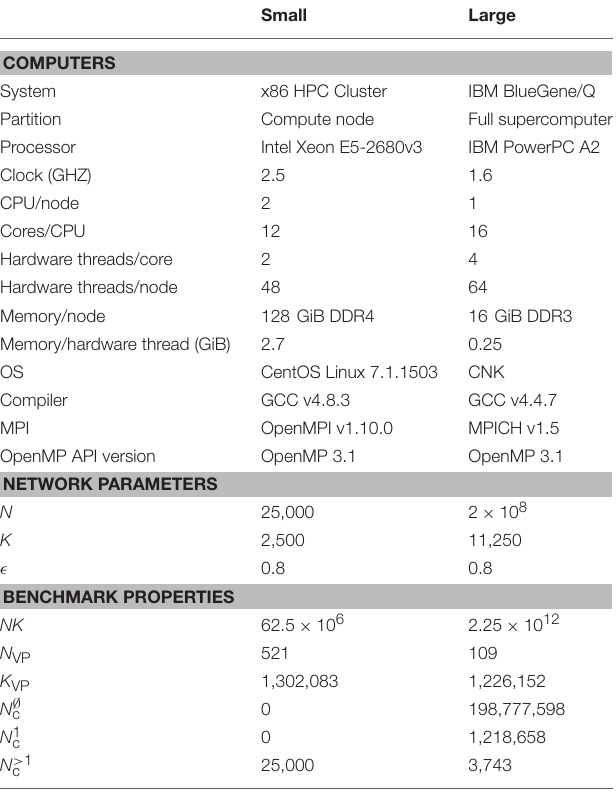
TABLE 1 | Parameters and properties of the small and the large benchmark. Small